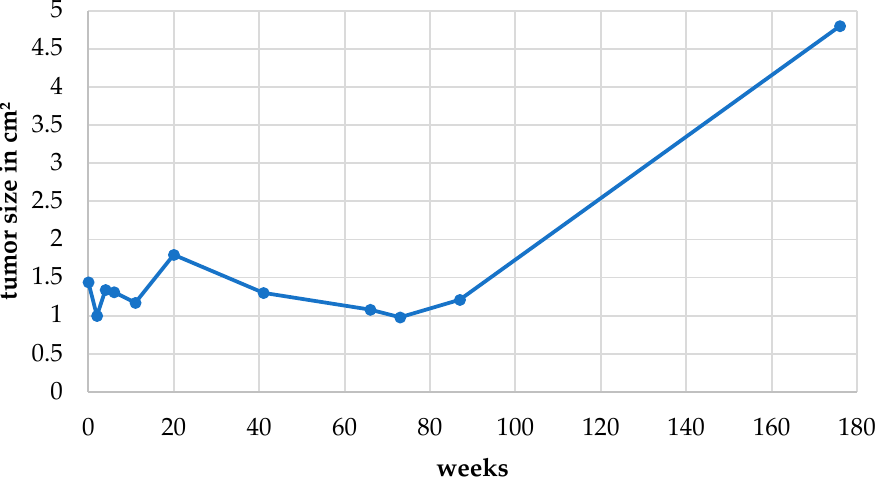
Figure 3. The tumor size was measured by sagittal bulbus ultrasonography, and data of length x width (cm 2 ) are presented from the first to last measurement 176 weeks later.